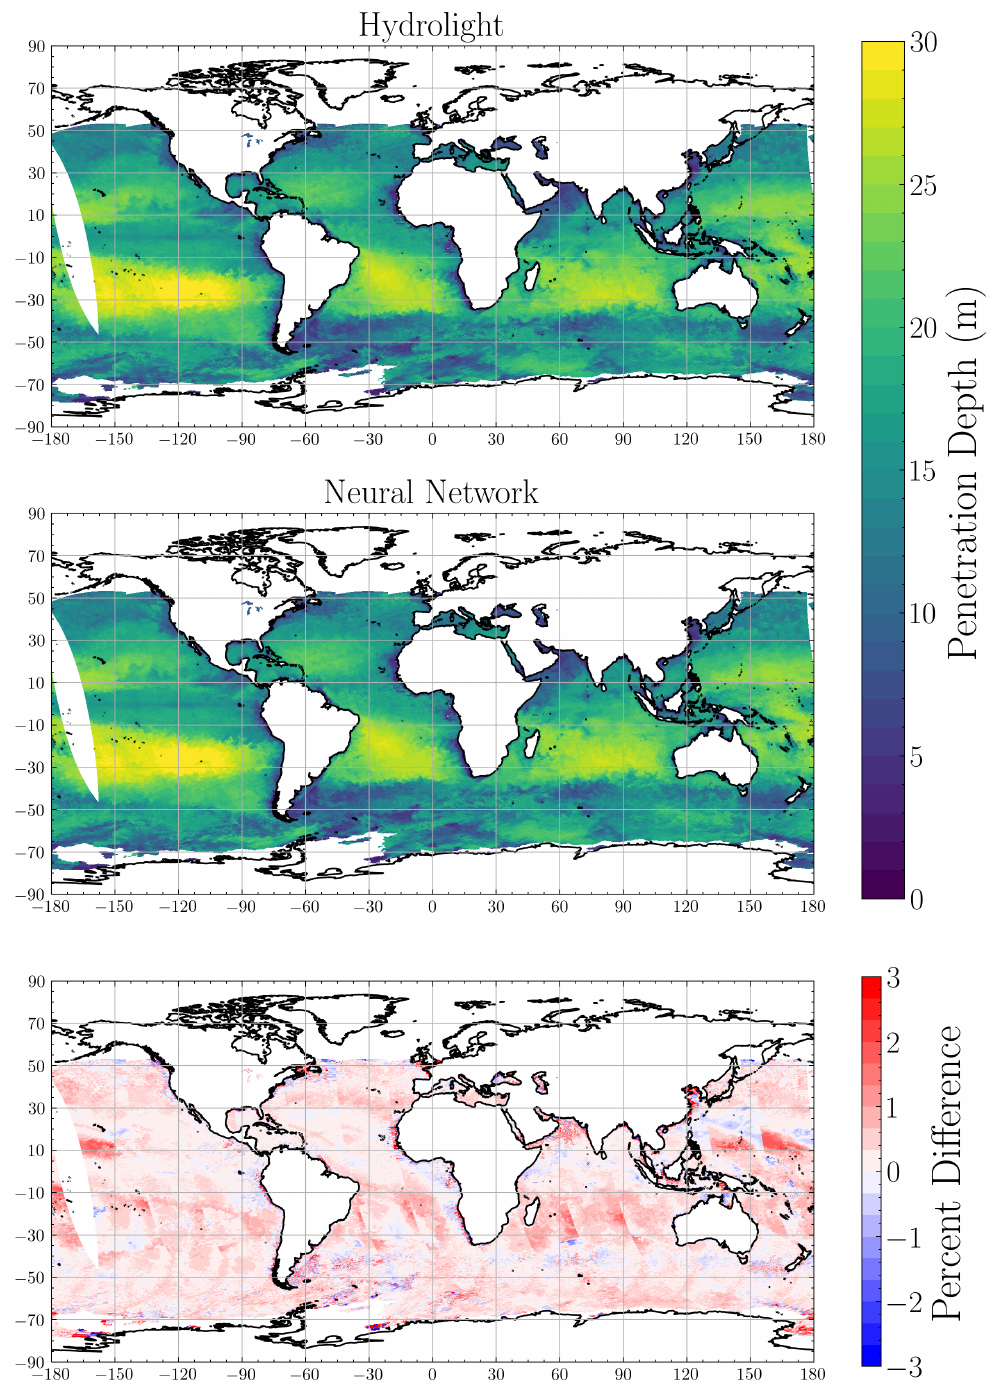
Figure 10. Map of planar penetration depth on 7 January 7 2005. Top panel shows planar penetration depth from Hydrolight, middle panel shows planar penetration depth from the neural network and the bottom shows the percent difference of Hydrolight versus the neural network estimate. The color bars represent the penetration depths in meters and the percent